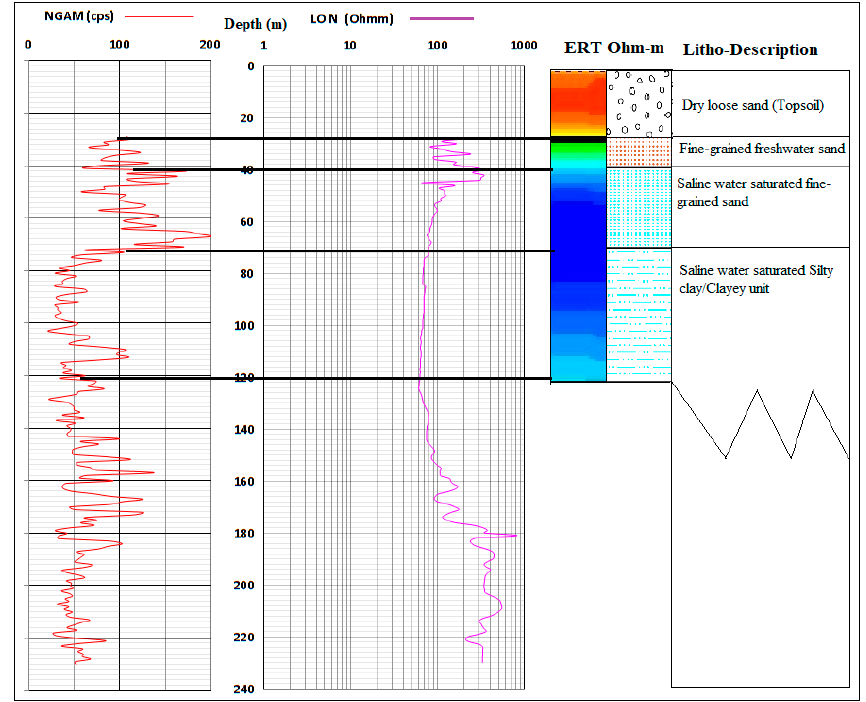
Figure 3. A lithological section showing the description of the vadose zone and aquifers of the southwestern coast of southwestern coast of Nigeria.